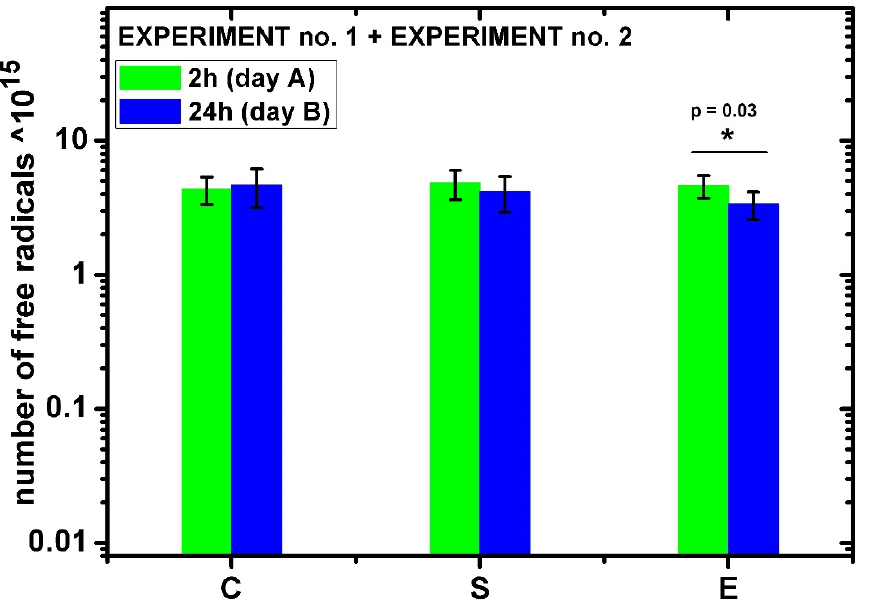
Figure 5. Representative EPR spectra of hMSC with CMH spin trap recorded at 2 °C: control samples (C, n = 6), sham samples (S, n = 6), and exposed samples (E, n = 6); * p = 0.03 for exposed samples after 2 h and 24 h. Measurement was performed in two independent experiments (with three independent biological specimens exposed in each experiment).